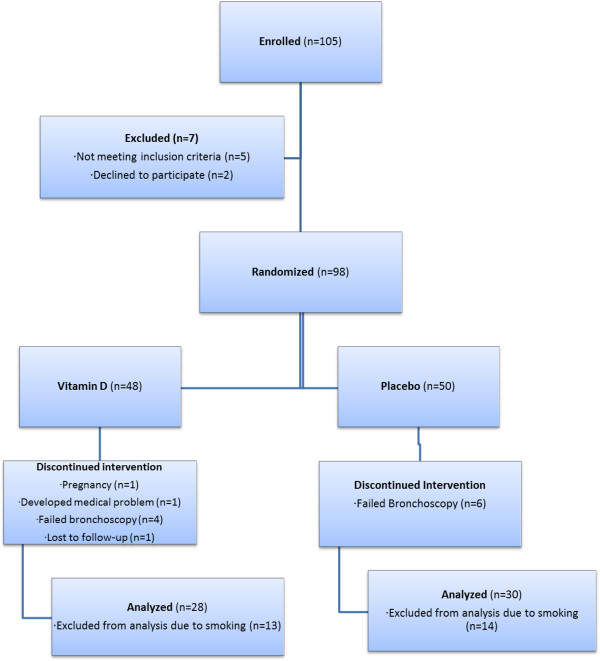
Subjects enrollment.